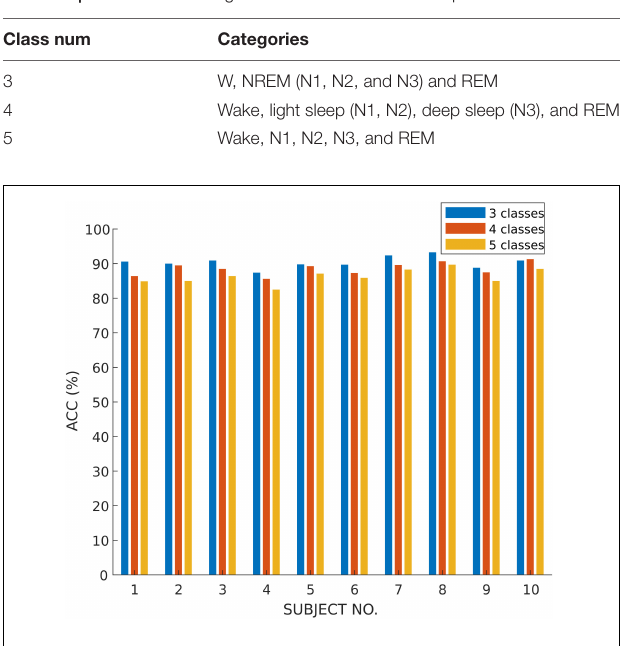
FIGURE 7 | The accuracy of multi-class classification experiments based on SLEEP-EDF.